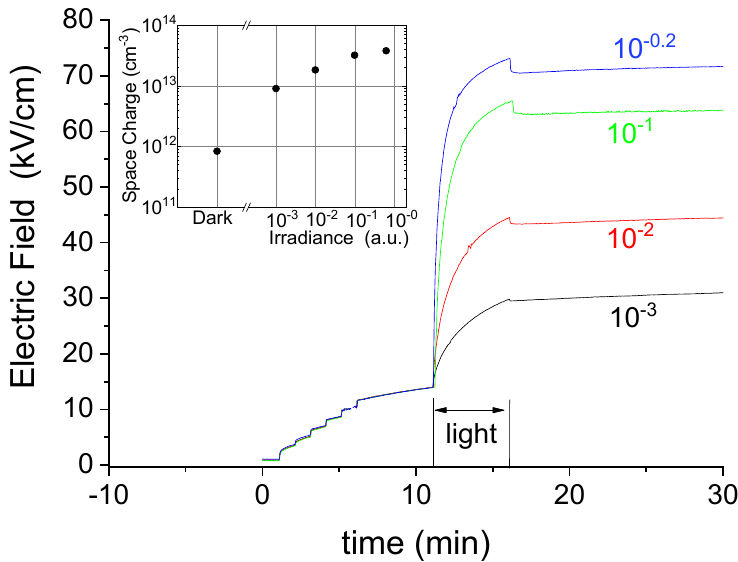
Figure 4. Electric field transients at the anode during the experiments under different optical irradiance. In the inset, the space charge under dark conditions (just before light) and under optical excitation, just before switching it off. The temperature was 40 °C. For each transient, the neutral filter optical density is reported.